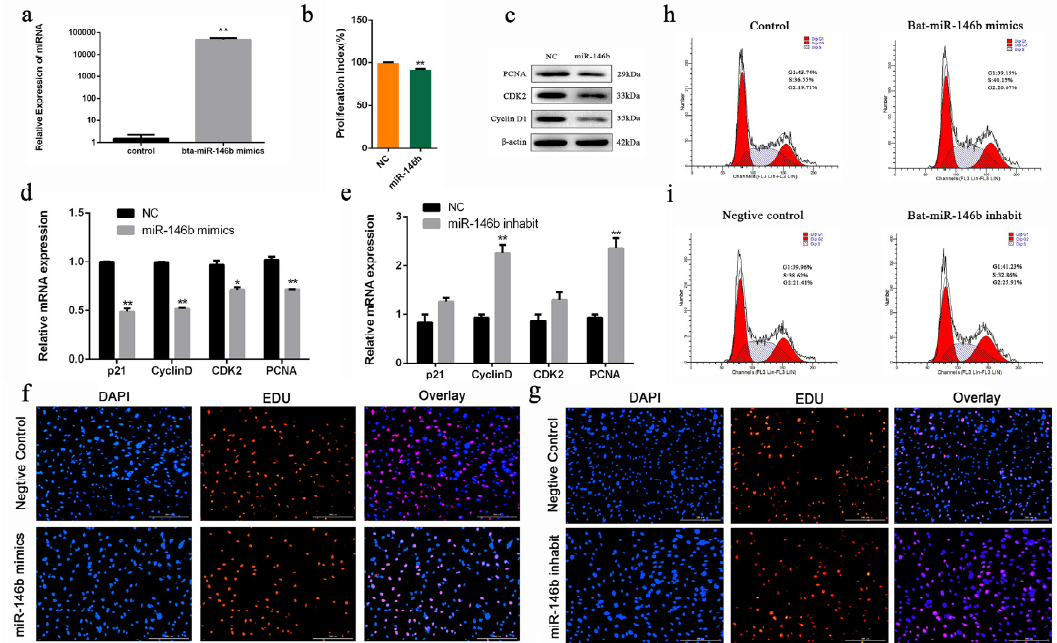
Figure 4. Bta-miR-146b regulates proliferation of bovine male germline stem cells. ( a ) The detection of bta-miR-146b expression efficiency after transfection of the bta-miR-146b expression plasmid by qRT-PCR. ( b ) Cell proliferation status was detected at 450 nm with CCK-8 reagent after overexpression of bta-miR-146b. ( c ) Cell cycle-related genes ( PCNA , CDK2 and Cyclin D1 ) protein expression level was detected by western blot analysis after overexpressing bta-miR-146b. ( d ) Cell cycle-related genes ( PCNA , CDK2 , cyclinD1 and p21 ) mRNA expression level was detected by qRT-PCR after a gain or loss ( e ) of bta-miR-146b. β -Actin was used as the reference gene. ( f ) EdU staining-positive muscle cells was detected by EdU kit after a gain or loss ( g ) of bta-miR-146b. EdU (red), DAPI (blue); the scale bars represent 200 µm. ( h ) Distribution of cell numbers in each cell cycle stage was detected by PI flow cytometry after the gain or loss ( i ) of bta-miR-146b. Data are presented as mean ± SEM; * p < 0.05 and ** p < 0.01. DAPI: 4 ′ ,6-diamidino-2-phenylindole; EdU: 5-ethynyl-2-deoxyuridine; miR: microRNA; mRNA: messenger RNA; NC: negative control; PI: propidium iodide; qRT-PCR: quantitative real-time polymerase chain reaction.